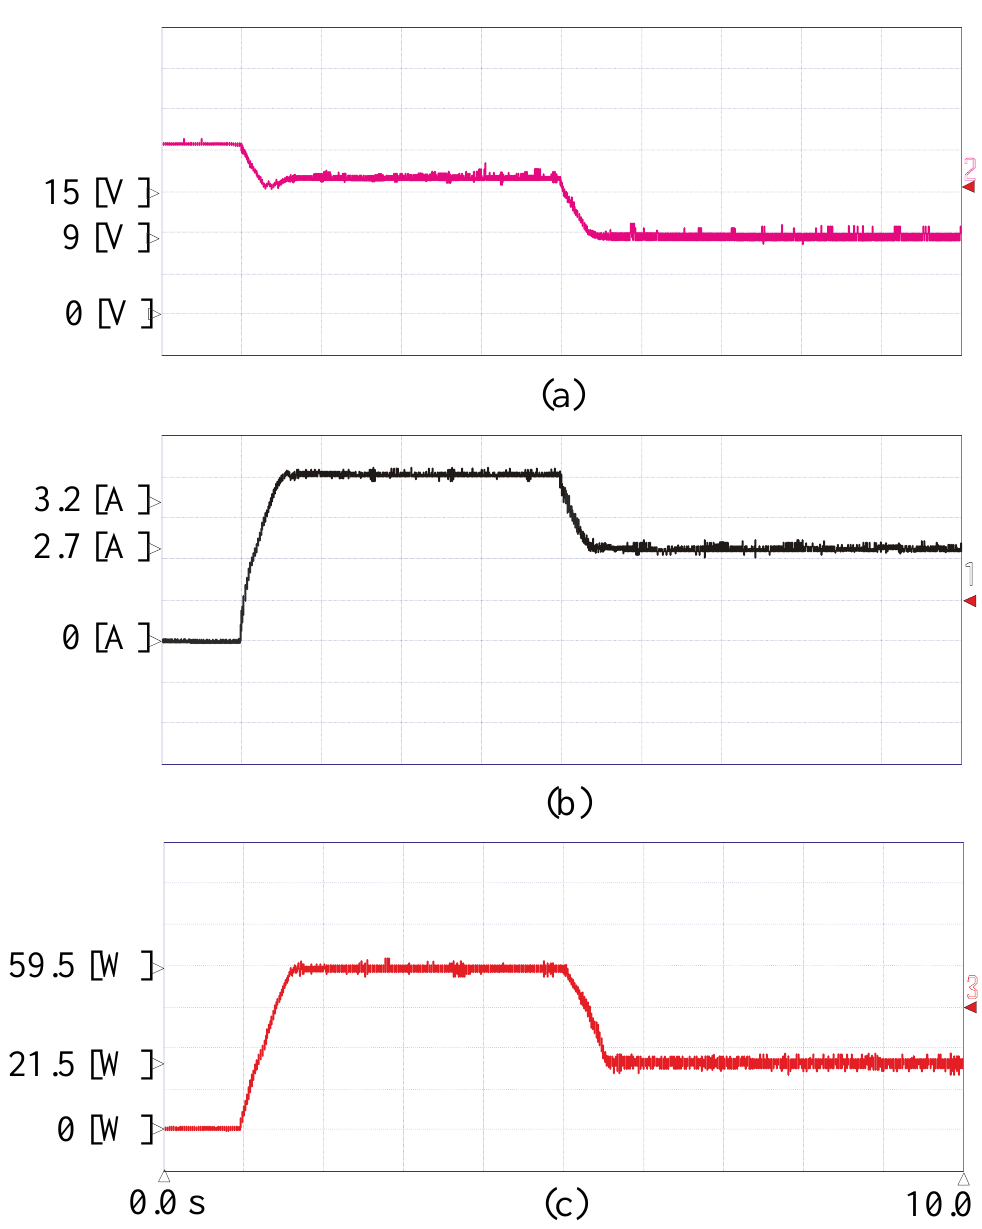
Figure 18. Experimental results of SA-P&O MPPT considering Case 2 ( a ) PV voltage, ( b ) PV current, and ( c ) PV power.